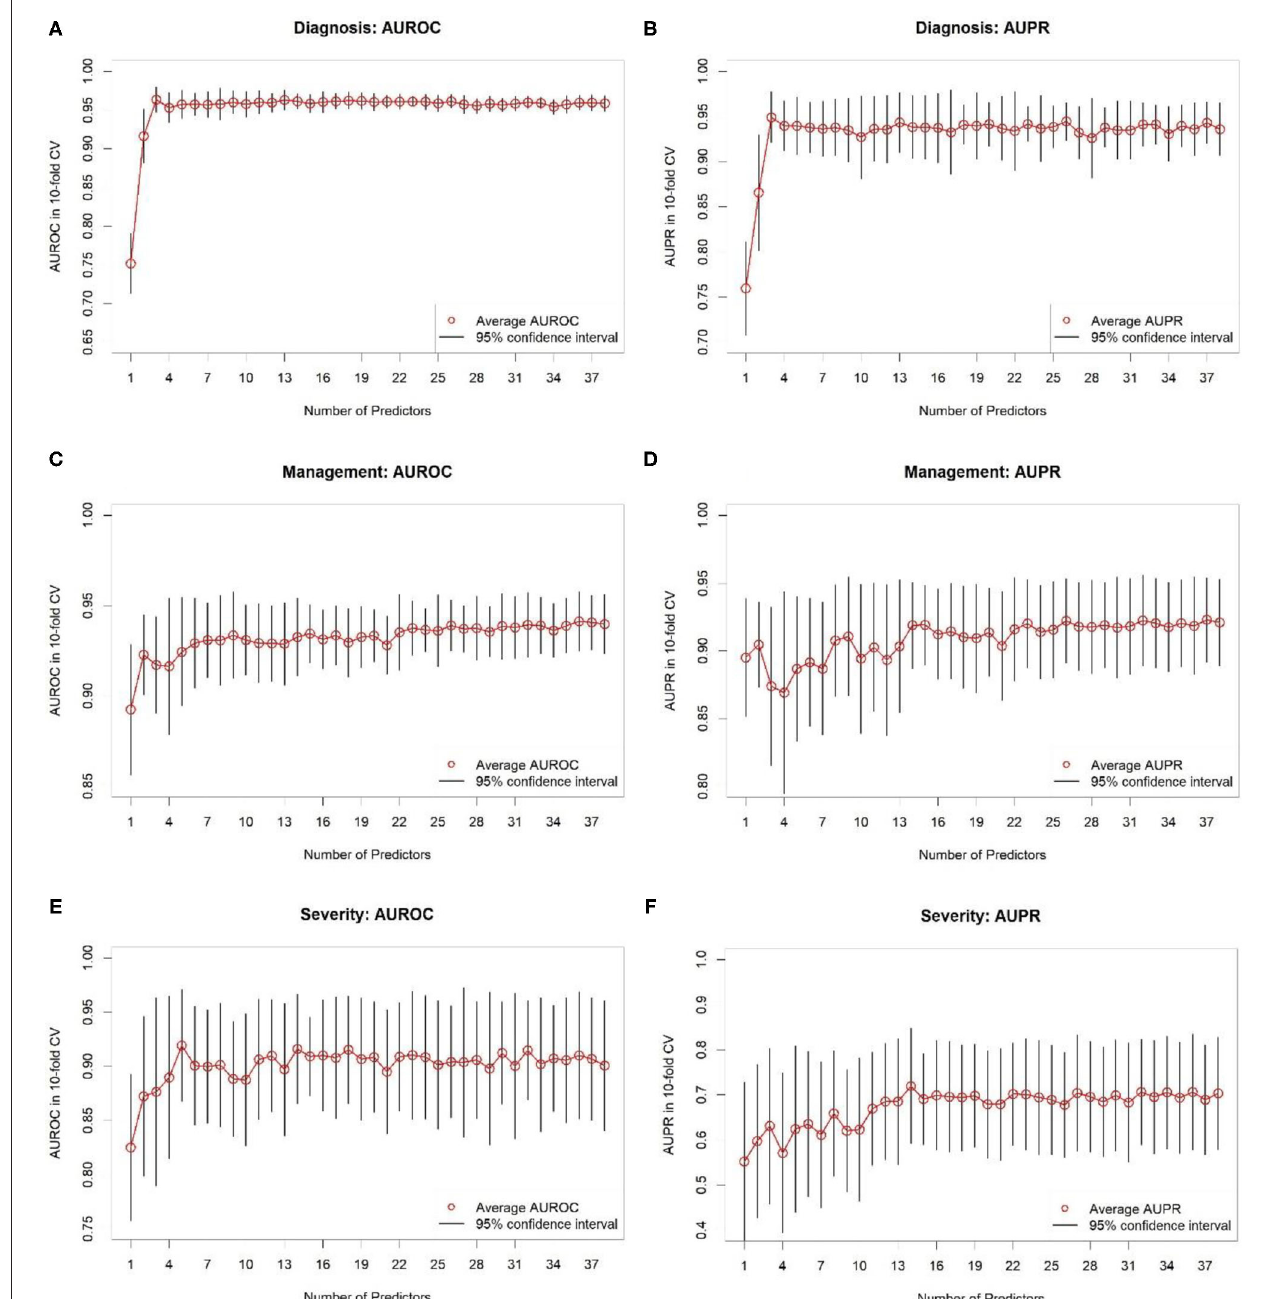
FIGURE 3 | Results of 10-fold cross-validation for random forest classifiers based on different numbers of predictor variables selected based on variable importance. (A,B) Show areas under receiver operating characteristic (AUROC) and precision-recall (AUPR) curves, respectively, for predicting diagnosis. (C,D) Show AUROCs and AUPRs, respectively, for predicting management. (E,F) Show AUROCs and AUPRs, respectively, for predicting severity. Black-colored bars correspond to 95% confidence intervals, constructed using t -distribution; red-colored dots correspond to averages. Recall that random classifier AUROCs are 0.50 for all three targets and random classifier AUPRs are 0.43, 0.38, and 0.12 for diagnosis, treatment, and complicated appendicitis, respectively.